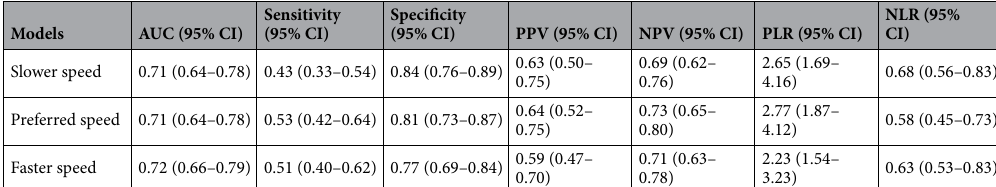
Table 3. Prediction results of the three different walking speed models of the XGBoost in the risk of falls. AUC area under the curve, NLR negative likelihood ratio, NPV negative predictive value, PLR positive likelihood ratio, PPV positive predictive value, CI confidence interval.